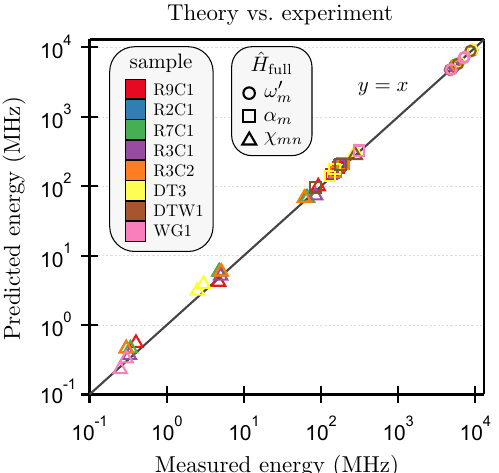
Fig. 4 Theory vs. experiment. Comparison between theory and experiment over fi ve-orders of magnitude in energy scale of the system Hamiltonian ^ H full for eight distinct, multi-mode device samples, described in detail in the “ Methods ” section, including 3D, fl ip-chip (2.5D), and 3D waveguide architectures incorporating readout and storage resonators and qubit modes. For each device, the dominant parameters in ^ H full , dressed frequencies ω 0 anharmonicities α m , and cross-Kerr interactions χ mn were measured and calculated using the EPR method with our open-source PY EPR package (see the PY EPR 95 code repository at http://github.com/ zlatko-minev/pyEPR). Gray line is of slope one, representing ideal agreement between theory and